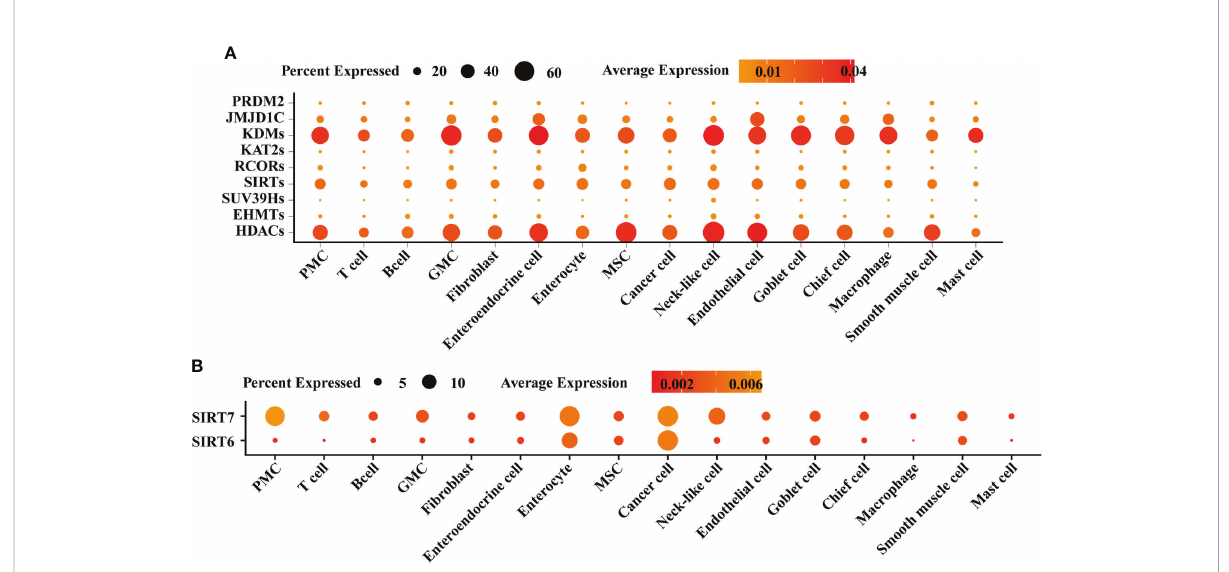
FIGURE 2 Single-cell atlas of gastric mucosae from patients suffering from chronic super fi cial gastritis, atrophy gastritis, intestinal metaplasia, and early gastric cancer. (A) Dot plot exhibiting the expression of histone modi fi cation genes across different cell types. (B) Dot plot exhibiting the expression of SIRT6 and SIRT7 across different cell